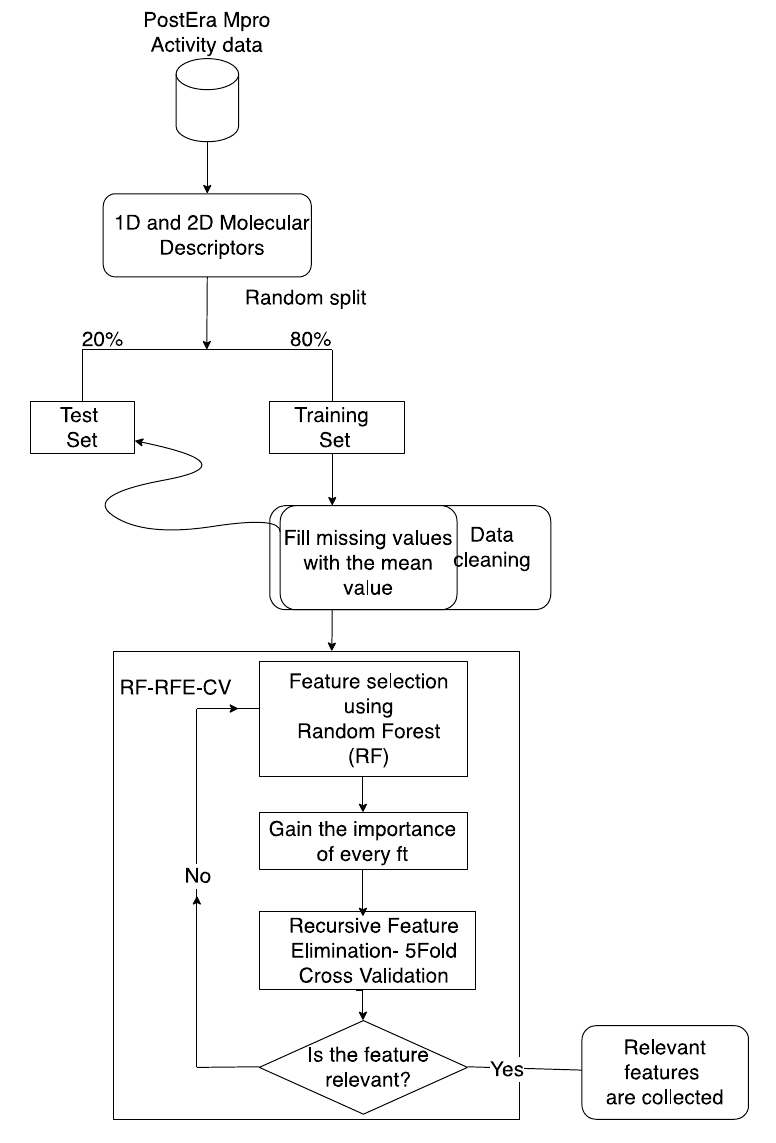
Figure 6. RF–RFE–CV data pre-processing and feature selection flowchart.